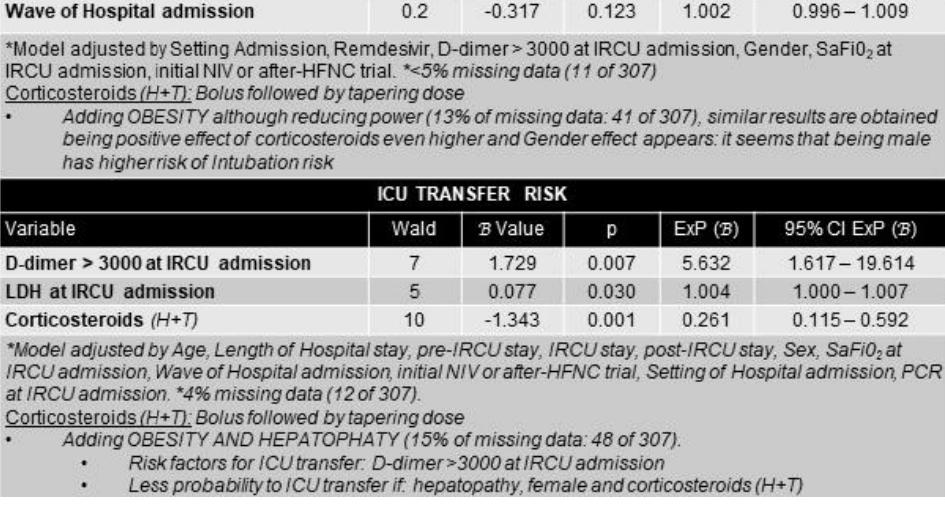
Figure 4. Multivariate logistic regression analysis. Factors associated with survival, ICU transfer, and intubation in the NIV group.